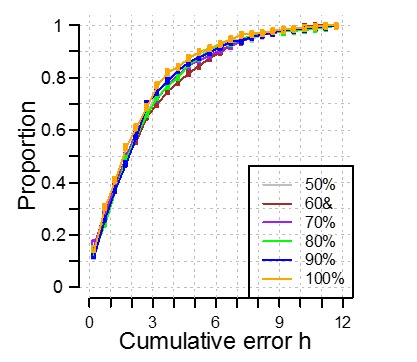
DOI:
http://dx.doi.org/10.7554/eLife.20214.024